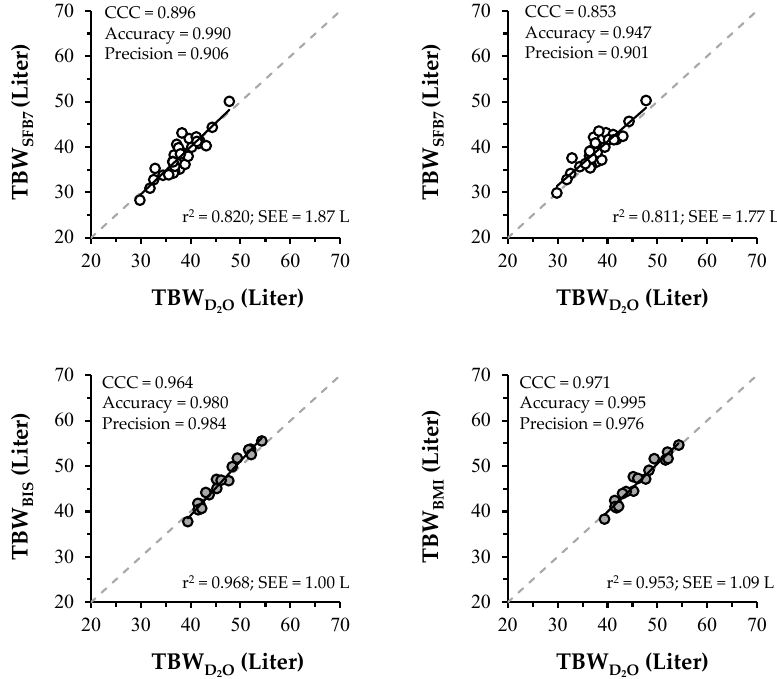
, non-athletes. • , athletes. r 2 and and TBW SFB7 or TBW BMI . ○ , non-athletes. ● , athletes. r 2 and Figure 1. Relationship between TBW D 2 O and TBW SFB7 or TBW BMI . 2 O (cid:35)